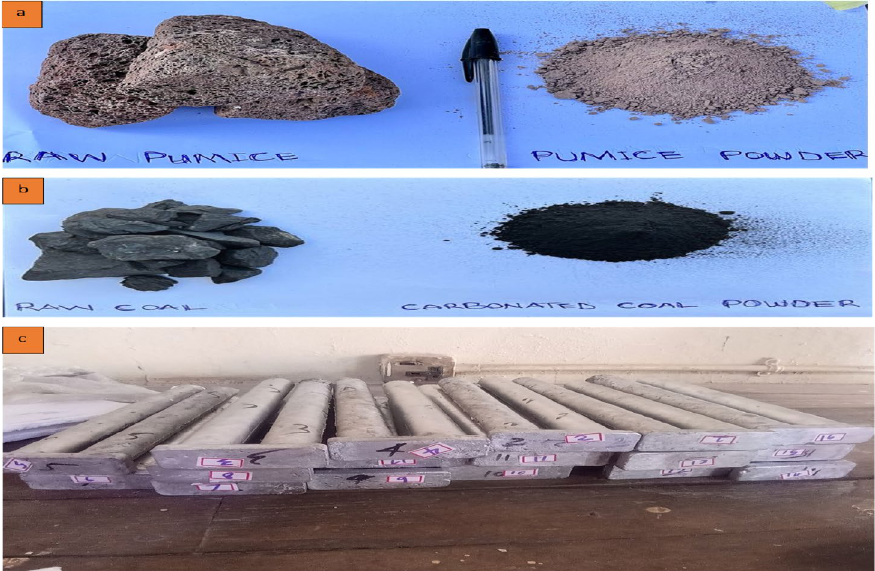
Figure 1. Reinforcements and cast composite ( a ) raw and powder pumice ( b ) raw and powder carbonated coal ( c ) cast hybrid aluminium